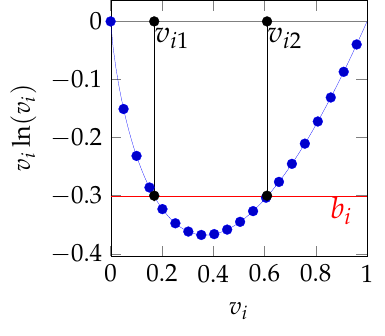
Figure 2. The v i ln v i